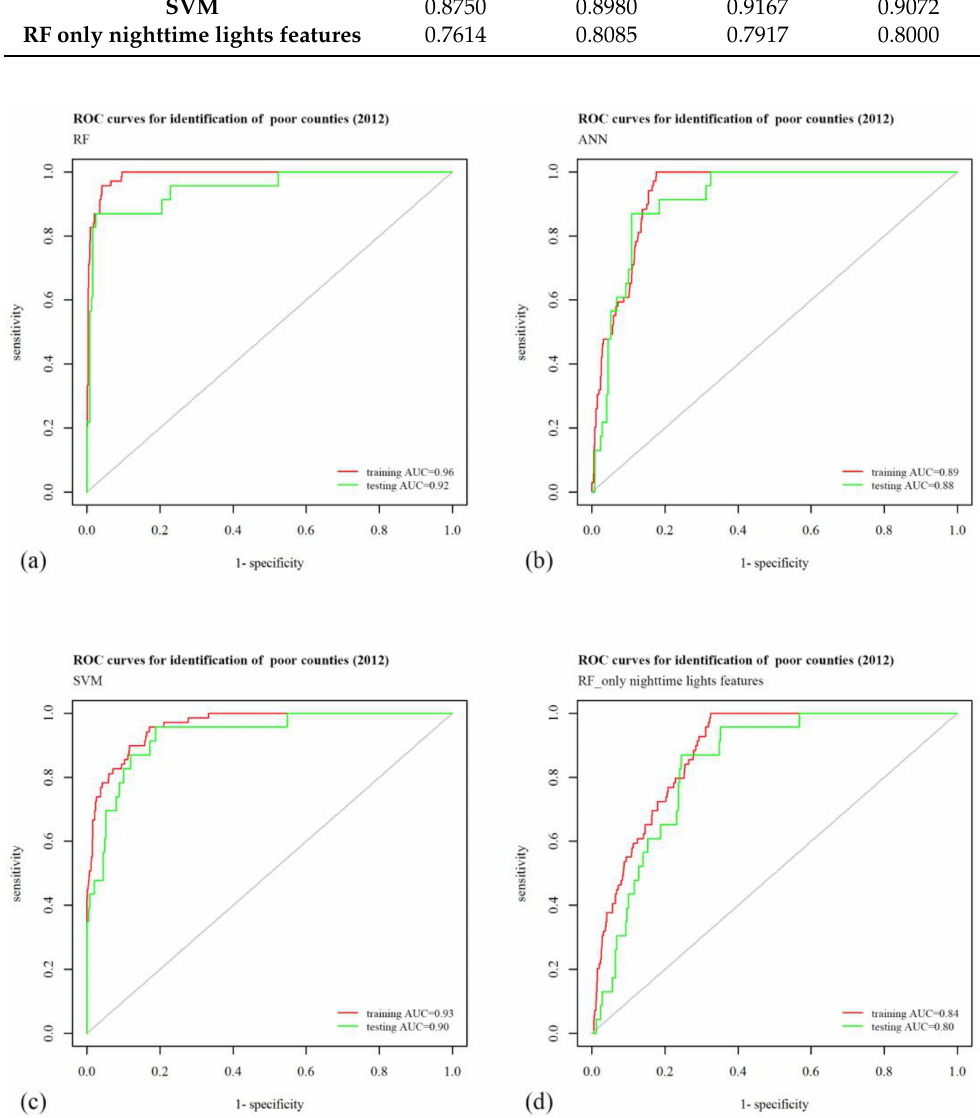
Figure 2. The Receiver Operating Characteristic (ROC) curves of poor counties identification in 2012. ( a ) ROC curves of poor counties identification by RF, ( b ) ROC curves of poor counties identification by ANN, ( c ) ROC curves of poor counties identifi-cation by SVM, ( d ) ROC curves of poor counties identifi-cation by RF_only nighttime lights